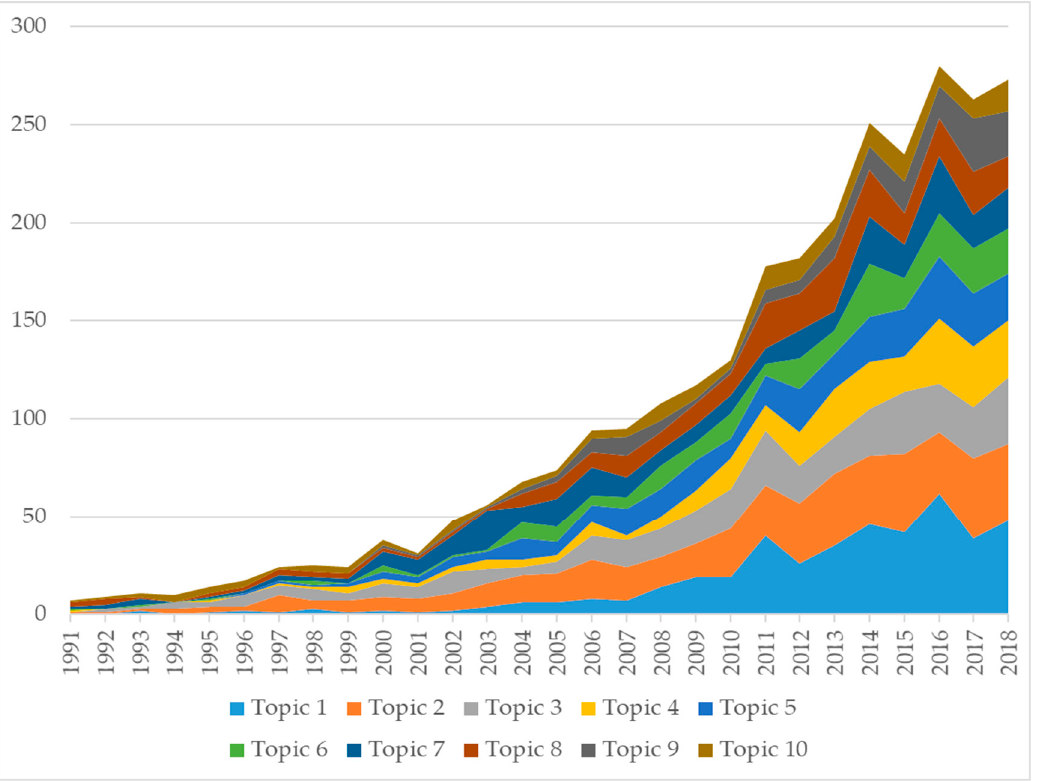
Figure 3. Changes in research topics development.